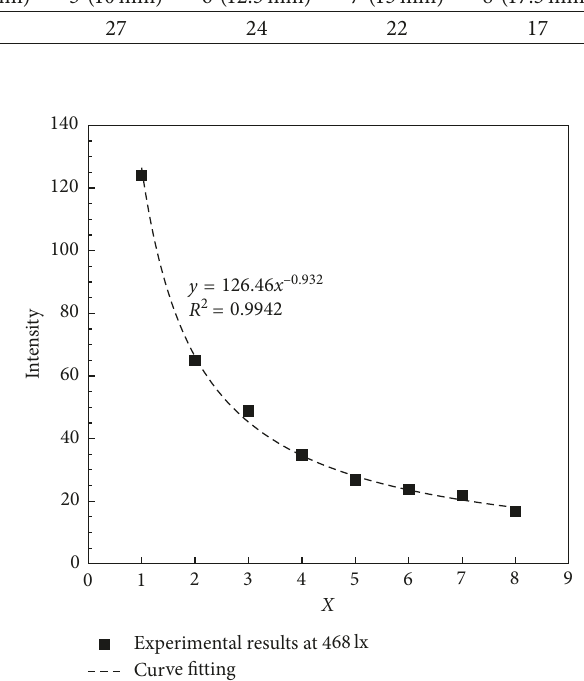
Figure 8: Approximate functions of intensity values.